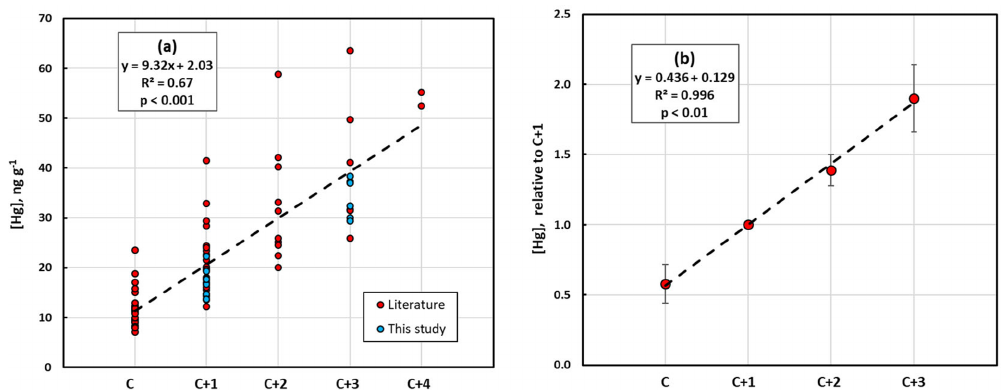
Figure 4. (a) Absolute mass-based concentration of mercury, [Hg] M , in different conifer species from the present study and data from the literature in relation to needle age (C is current year, C + 1 is 1 year old, etc.). (b) Averages of mass-based concentration of mercury, [Hg] M , from the present study and from the literature in relation to needle age as values relative to the concentration in the 1-year-old (C + 1) needle age class. For each data set the [Hg] M of the different needle age classes was divided by the [Hg] M of the C + 1 to create a relative scale. Error bars show standard deviation.